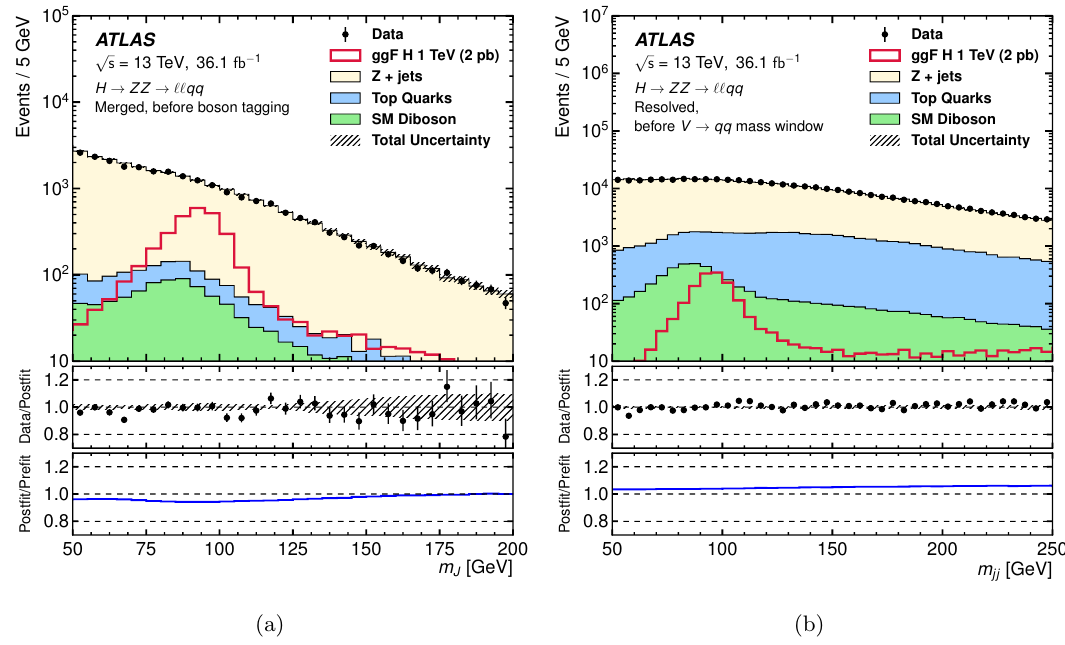
Figure 3 . Observed and expected distributions of (a) the large- R jet mass m J of the ZV candidate and (b) the dijet mass m jj of the ZV